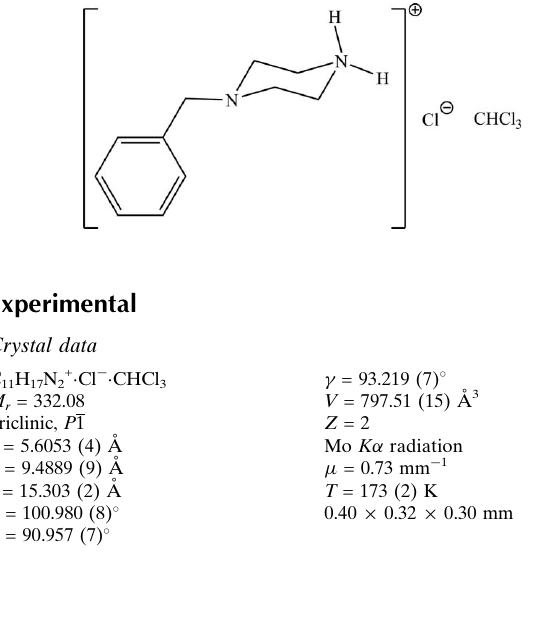
DIAMOND (Brandenburg & Putz, 2006); software used to prepare material for publication: publCIF (Westrip,